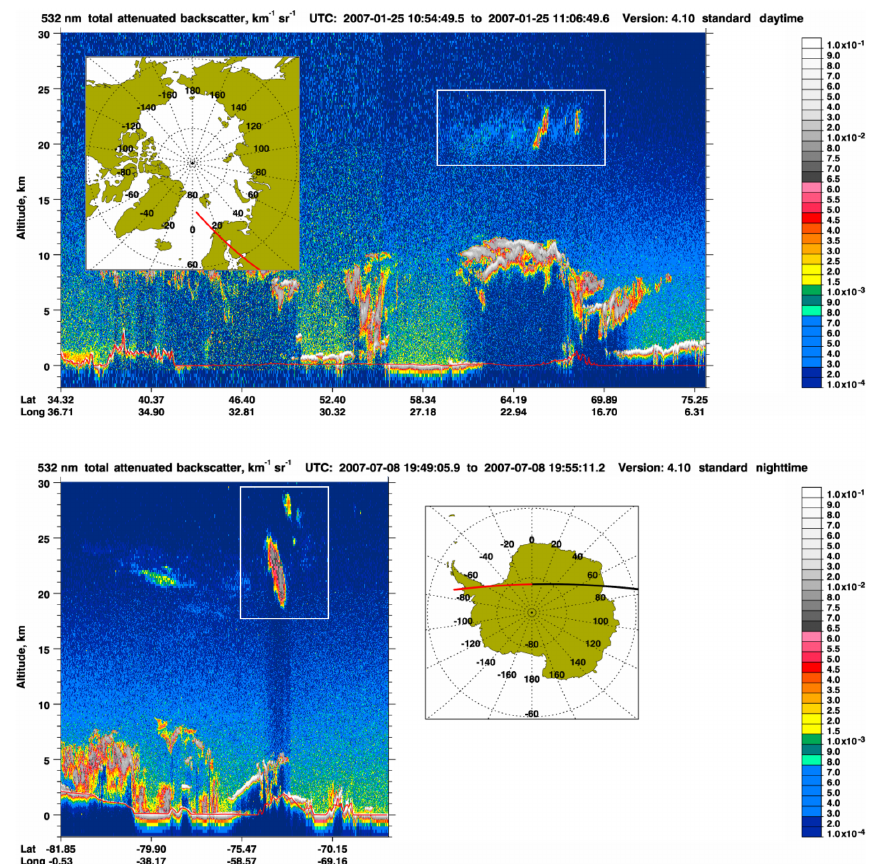
Figure 12. CALIOP browse images of 532nm total attenuated backscatter for two of the case studies presented in Fig. 11. The inset maps show the satellite track, and the white boxes indicate the features associated with polar stratospheric clouds.